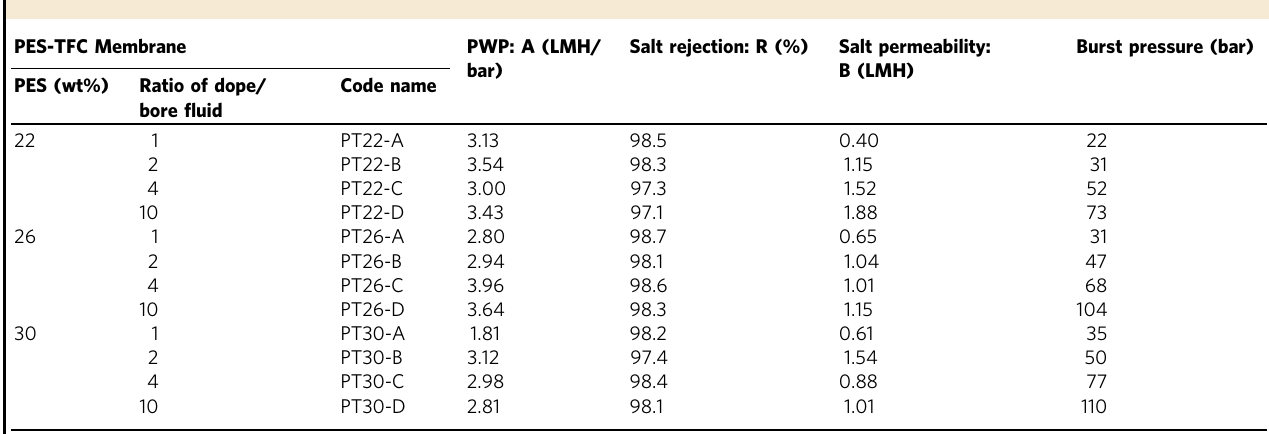
Table 2 Characteristics of the PES-TFC hollow fi ber membranes a . PES-TFC